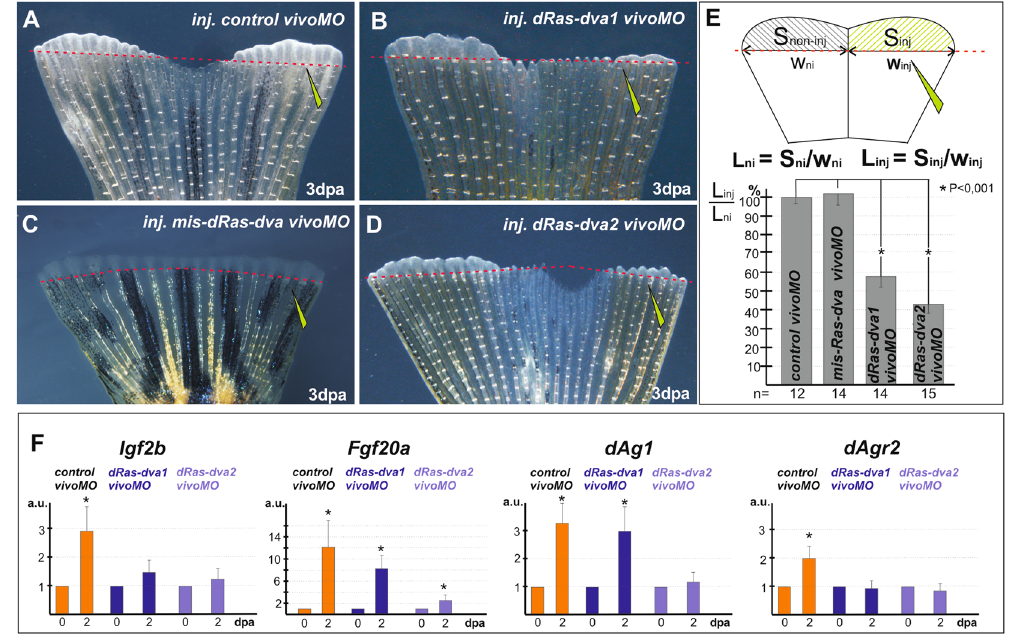
Figure 6. Down-regulation of Ras-dva genes by vivo-morpholino oligonucleotides inhibits the D. rerio fin regeneration. ( A – D ) Transmitted light images of regenerating D. rerio caudal fins injected in the right half by control vivoMO ( A ), dRas-dva1 vivoMO ( B ), mis-dRas-dva1 vivoMO ( C ) or dRas-dva2 vivoMO ( D ) at 3 dpa. Red dashed line indicates amputation level. Distal is upside, dorsal is to the left. Scale bar 200 µ m. ( E ) Regeneration efficiency is calculated as normalized area of regenerated part of the caudal fin at 3 dpa injected by vivoMO divided by the normalized area of regenerated part that was not injected. Resulting values were taken as a percentage of the value obtained for control vivoMO . The scheme demonstrates how normalized length value < L > was calculated. S – square mean, W-width mean, ni- non-injected part, inj-injected part. Error bars indicate SD. Statistical significance was determined with two-tailed t-test, the results are statistically significant, p < 0,001 (asterisk). ( F ) qRT-PCR analysis of the expression of early regeneration marker genes Igf2b and Fgf20a , as well as Agr genes, dAg1 and dAgr2 , during the regeneration process (at 0 and 2 dpa) in the D. rerio caudal fins injected with control , dRas-dva1 or dRas-dva2 vivoMO . The scheme of experiment is the same as described in Fig. 2A. The value of normalized PCR signal in the 0 dpa sample, harvested immediately after amputation, was taken as an arbitrary unit (a.u.) in each series. Dpa - days post amputation. Error bars indicate SD, t-test, p < 0.05